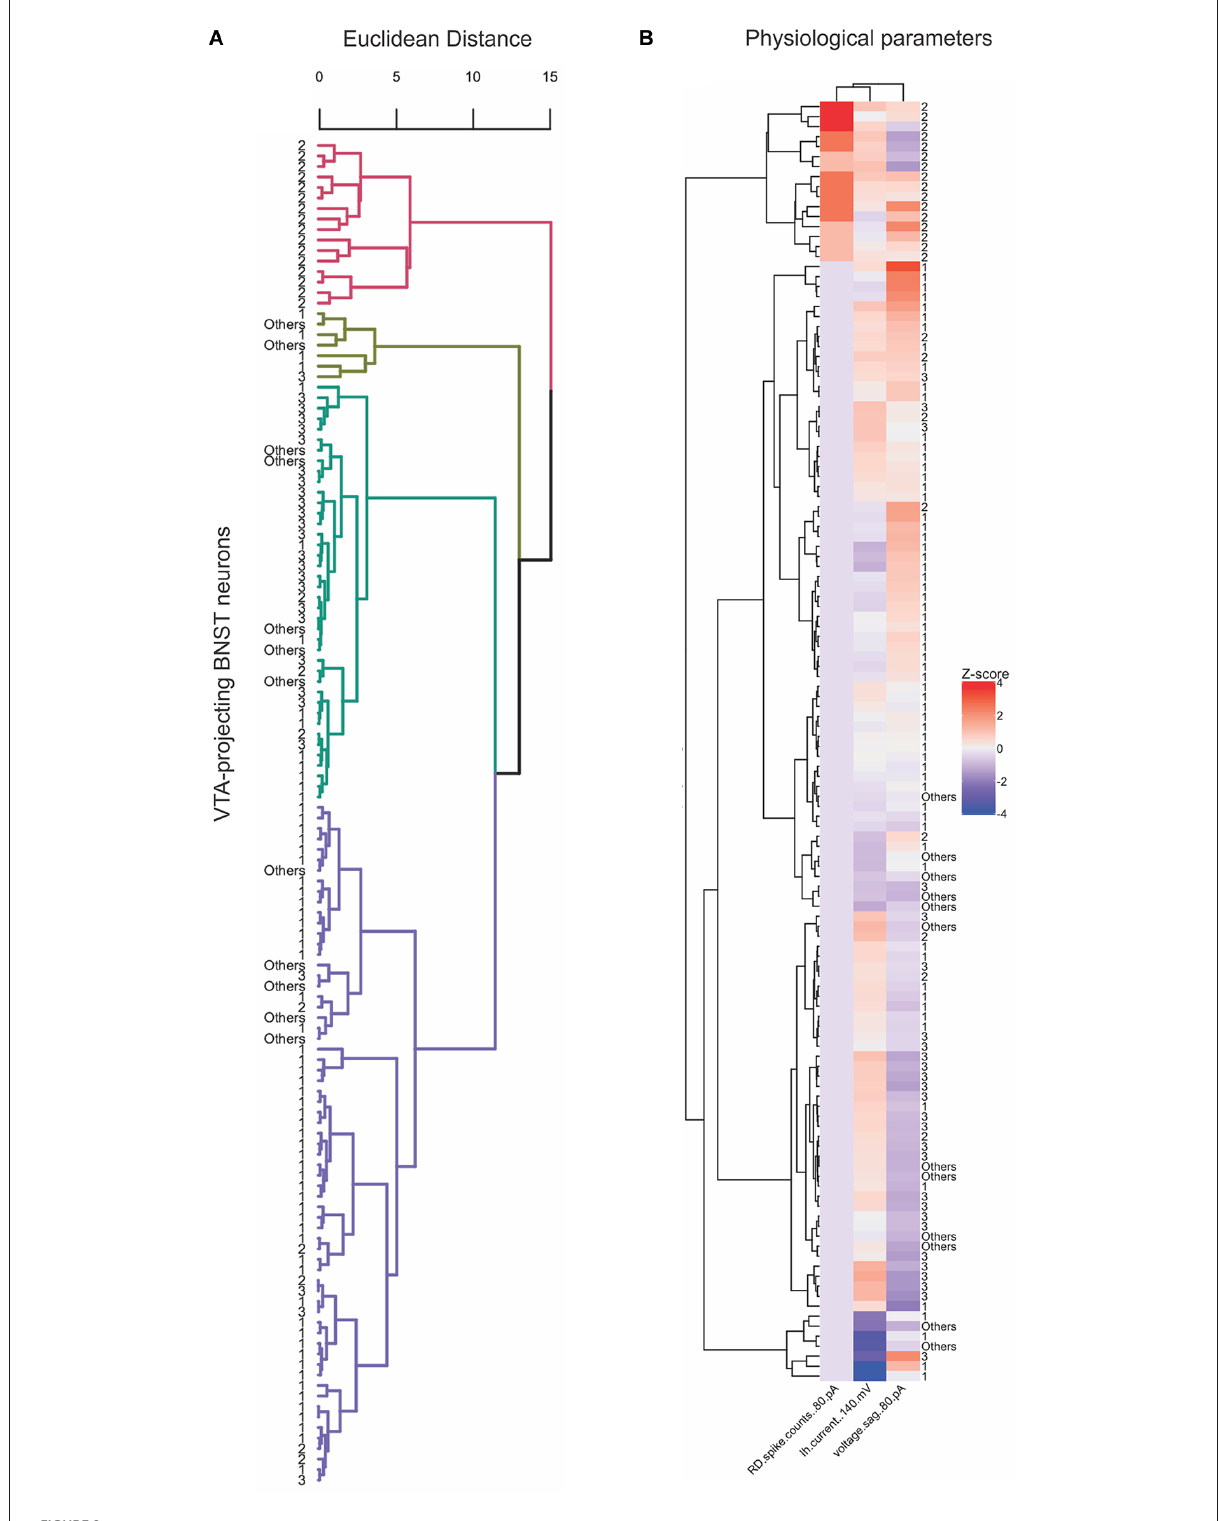
FIGURE9 Four preliminary clusters emerge from the unsupervised hierarchical analysis of three electrophysiological parameters of VTA-projecting BNST neurons. (A) Dendrogram showing hierarchical clustering using Euclidean distance and Ward’s method ( n = 128 neurons, n = 22 mice). (B) Heatmap of neuron features clustered neurons and physiological parameters that were used for